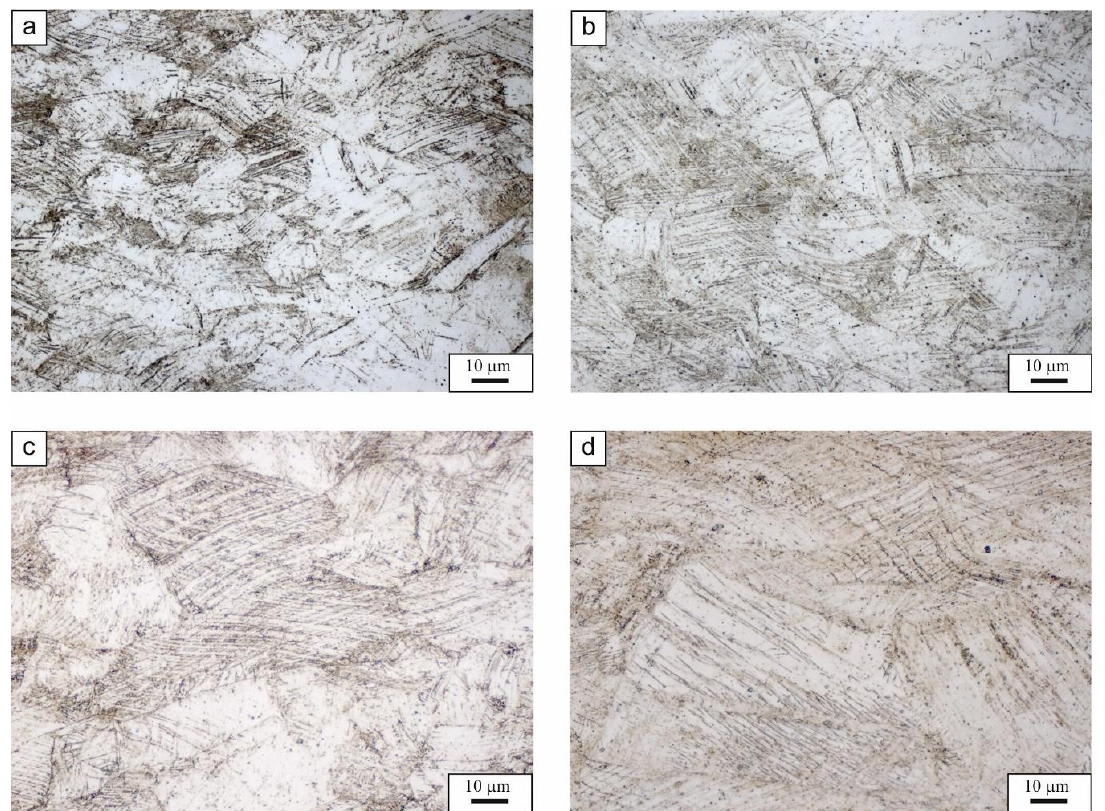
Figure 4. Austenite microstructures with numerous slip bands and twins after tensile tests; the solution annealing temperature: 900 ( a ), 1000 ( b ), 1100 ( c ), and 1200 °C ( d ).